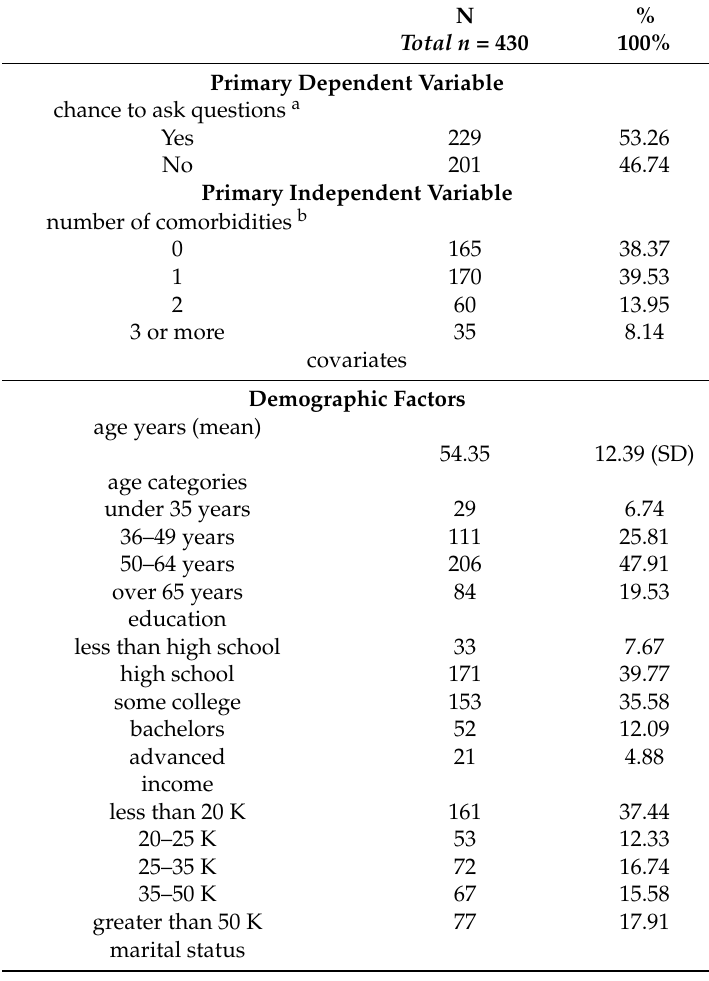
Table 1. Univariate Frequencies and descriptive of measures of interest, MMHS, 2011. Analytic Sample: African American Males.